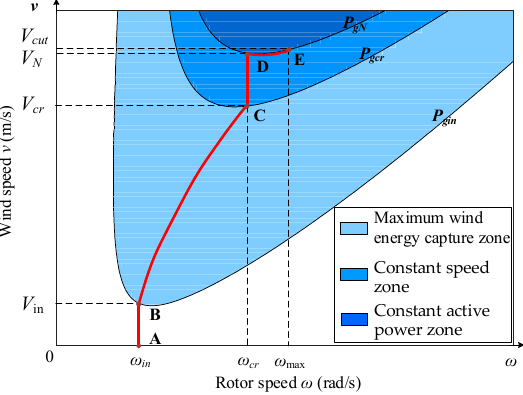
Figure 2. The operation characteristics of DFIG based on P g , v and ω .